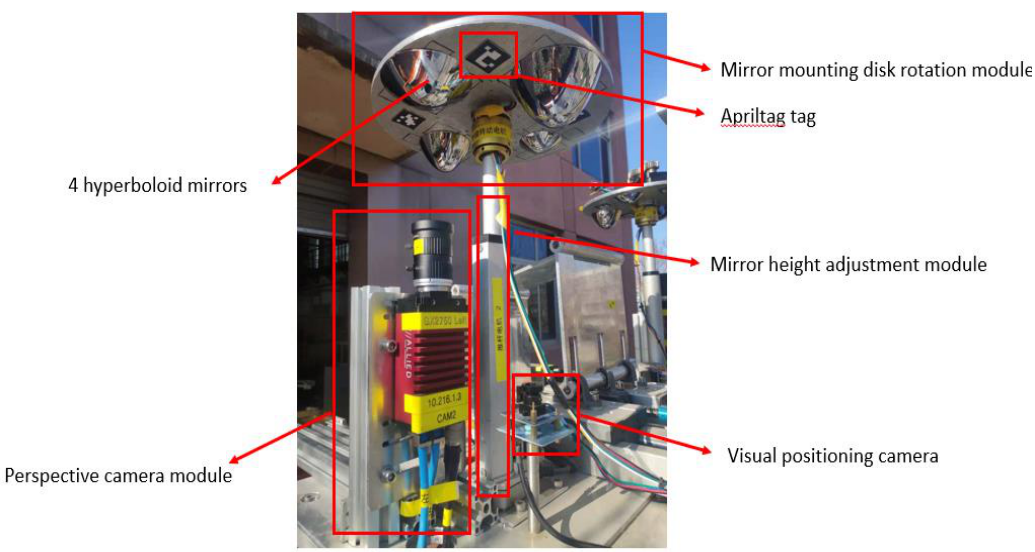
Figure 7. The physical picture of monocular panoramic vision systems.